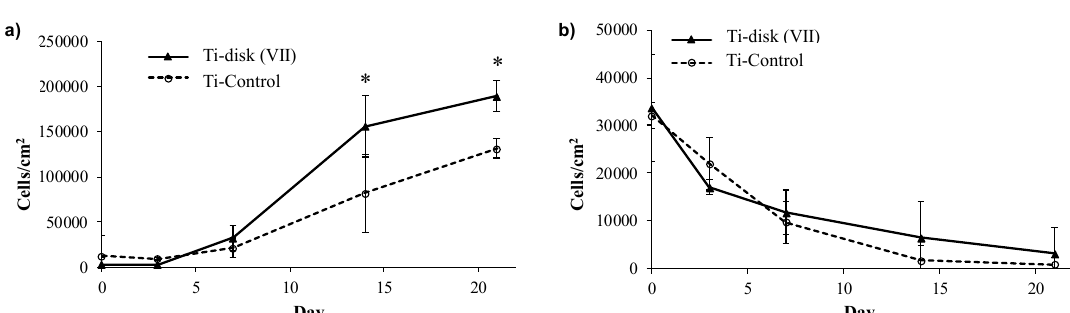
Figure 4. Environmental scanning electron microscopy (ESEM) of human osteoblastic cells seeded onto nude and RGD-coated titanium disks, 1 and 3 days after seeding. ( A ) and ( C ) correspond to Ti Control, while ( B ), ( D ) and ( E ) correspond to Ti disk (VII). The arrow in D points to a cell that is bridging the gap between two protrusions of the titanium surface, by means of a filopodium boxed in D and magnified in E. Bars: 50 µ m in A-B, 25 µ m in C-D, and 10 µ m in E.